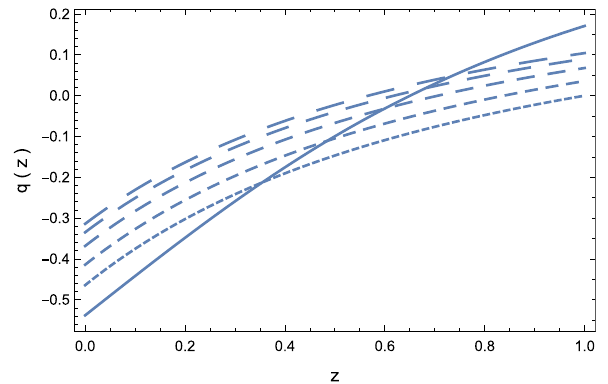
Fig. 3 Variation of the deceleration parameter q as a function of the redshift z in the f ( Q , T ) gravity theory for f ( Q , T ) = − α Q − β T 2 andforadustUniverse,fordifferentvaluesoftheparameter λ : λ = 1 . 52 (dottedcurve), λ = 1 . 64(shortdashedcurve), λ = 1 . 75(dashedcurve), λ = 1 . 83 (long dashed curve), and λ = 1 . 88 (ultra long dashed curve), respectively. The variation of the deceleration parameter in the standard (cid:4) CDM model is also represented as the solid